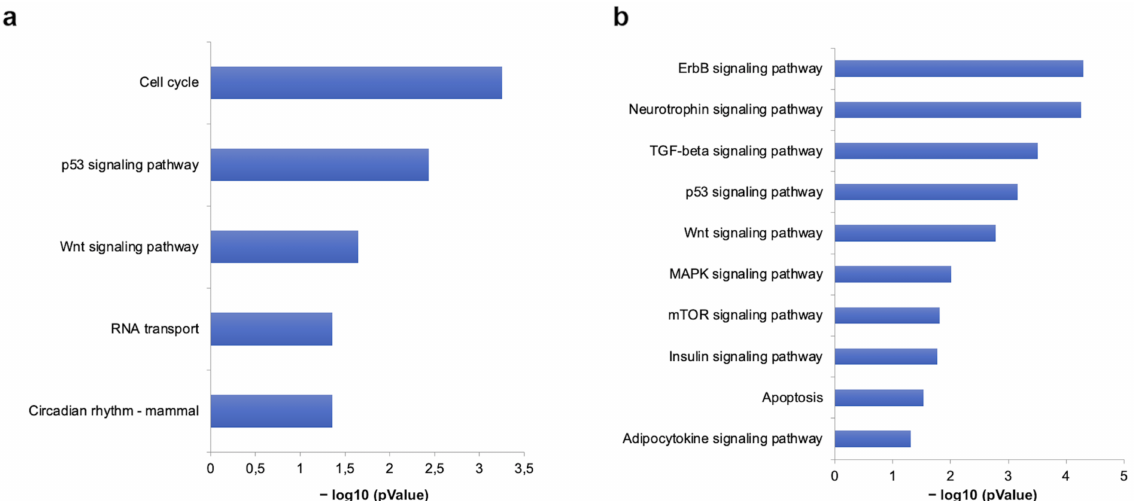
Figure 6. Gene set enrichment analysis of KEGG pathways of miR-499-5p and miR-125b-5p. Pathways modulated at baseline ( a ) and follow-up ( b ) by differentially expressed miRNAs, expressed as negative logarithm of p -value ( −